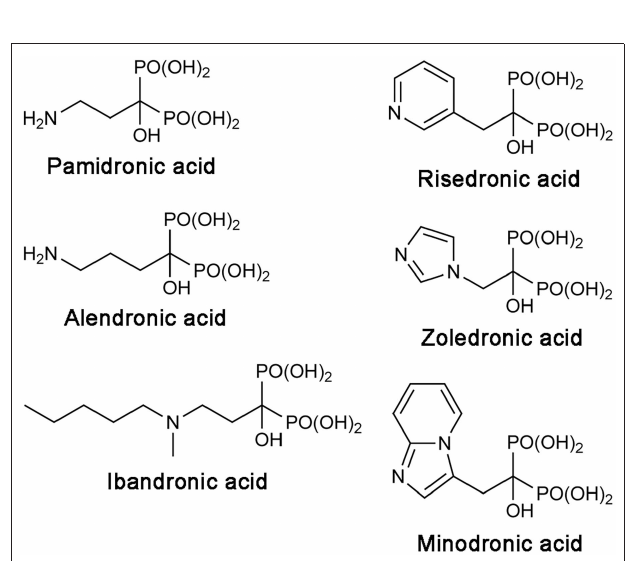
FIGURE 2 | Structures of clinical N-BP